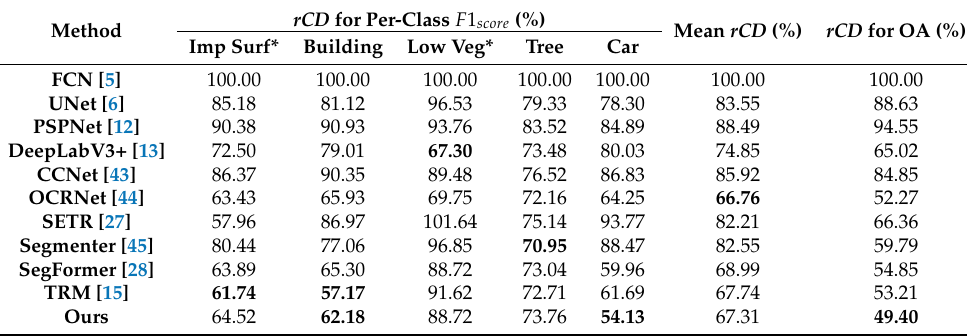
Table 10. Quantitative evaluation of rCD on clean and fog corrupted variants of Potsdam test set about different SOTA methods. FCN is regarded as the reference and values lower than 100% represent an improvement in the robust performance compared to the reference. The minimum in each column is in